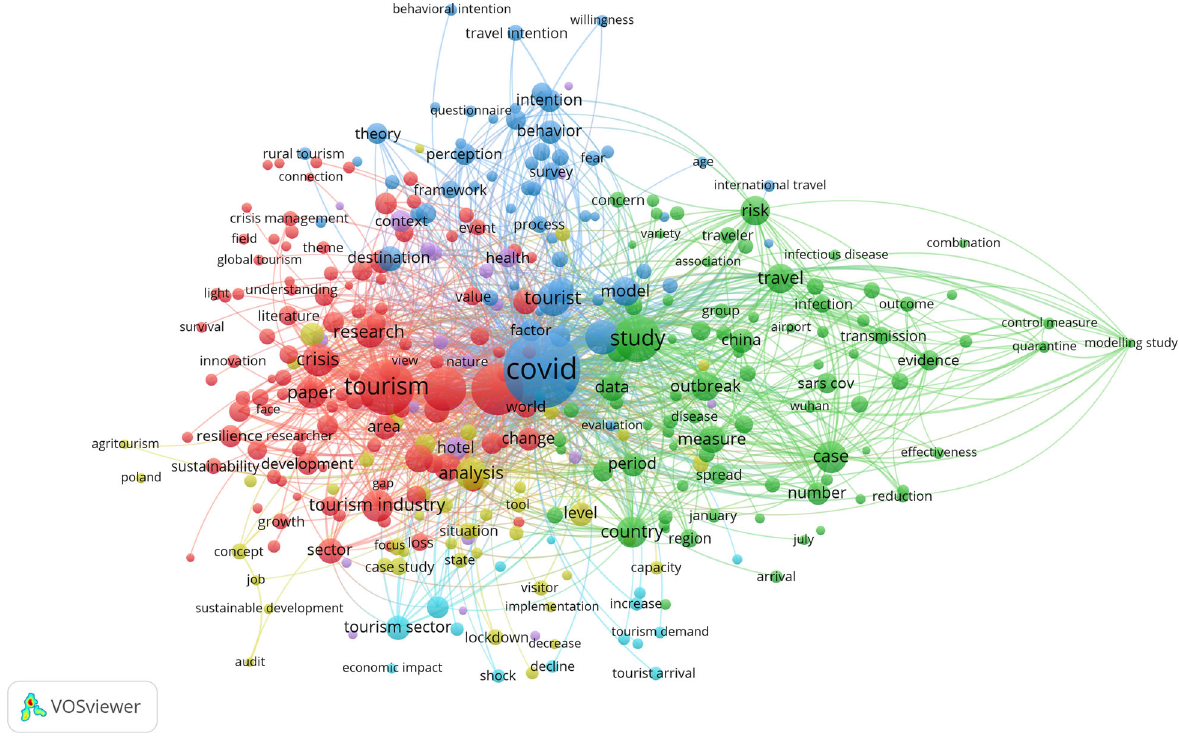
Fig. 2 Keywords. Co-occurrence of keywords in COVID-19 and tourism publications.